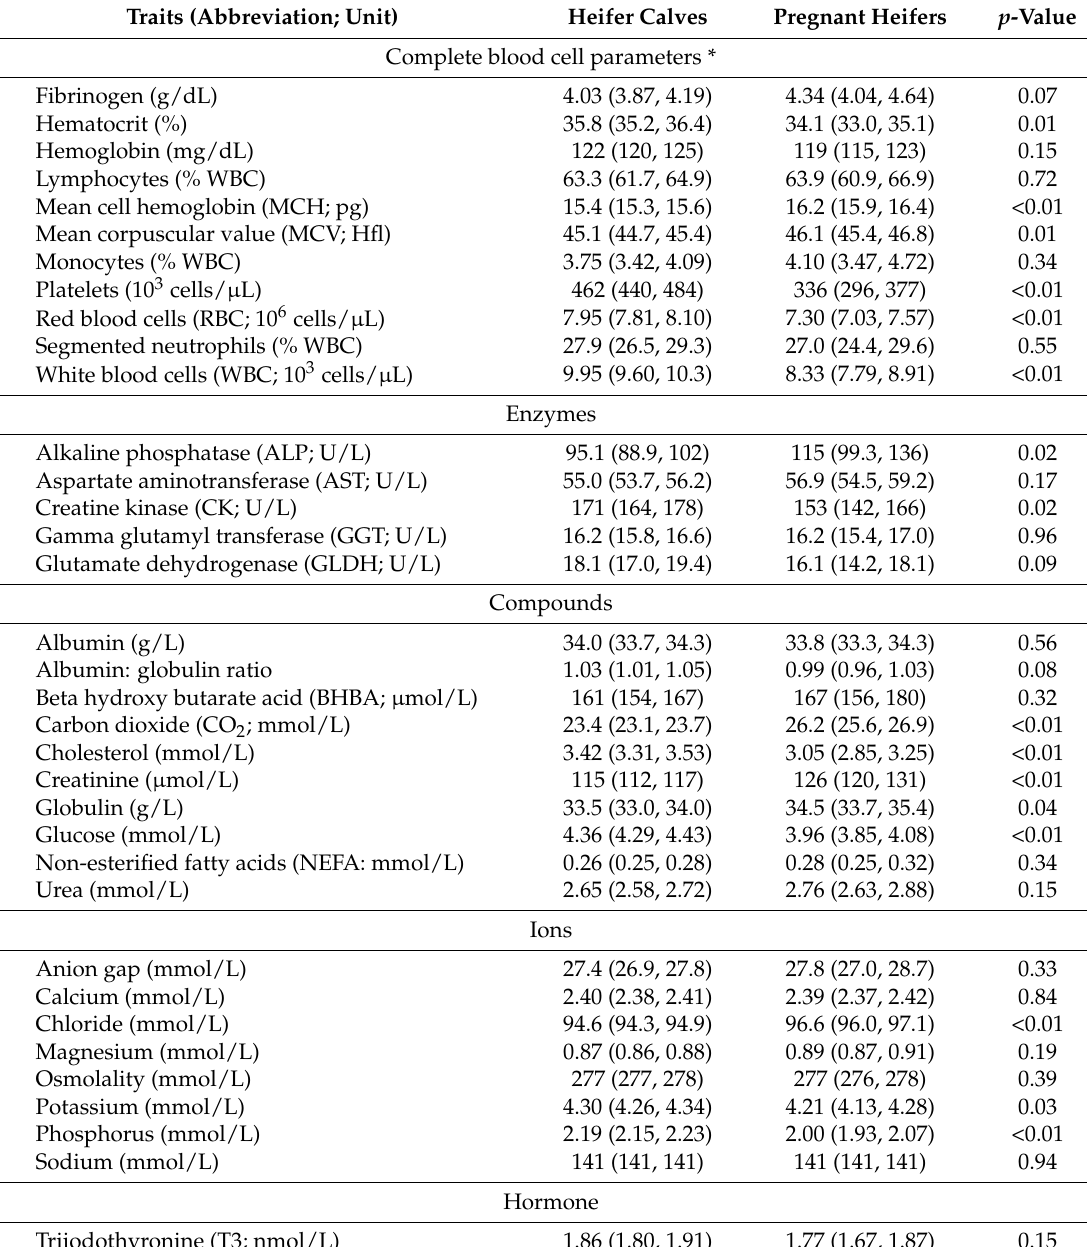
Table 3. Least square means comparison (confidence interval) of blood cell parameters and plasma metabolites between heifer calves and pregnant